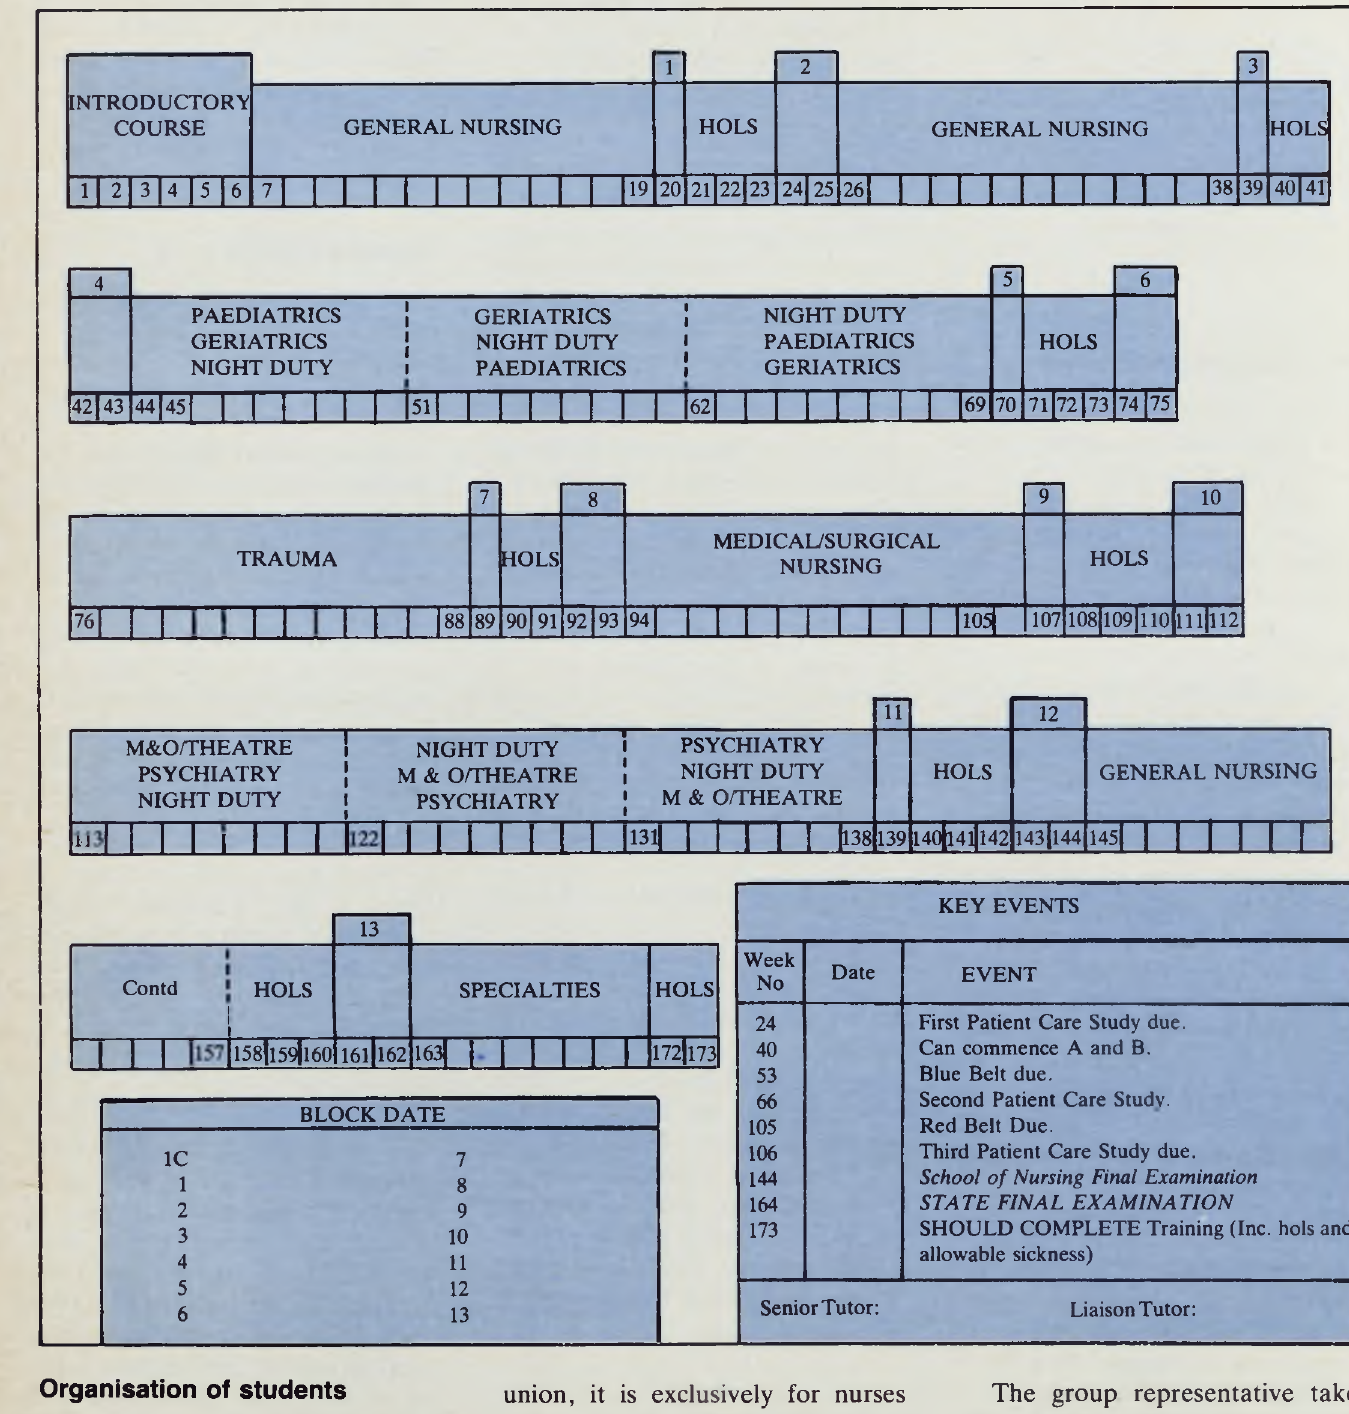
Table 2 THE SHEFFIELD SCHOOL OF NURSING STUDENT PLAN OF TRAINING